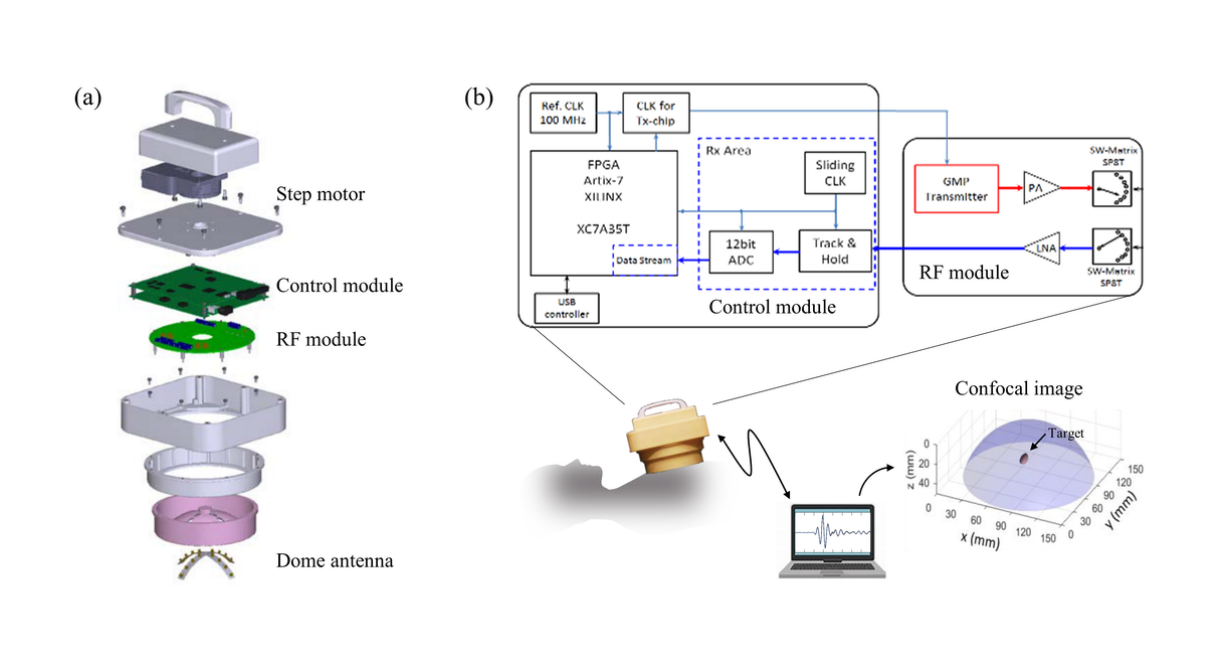
Figure 2. Structure of the microwave breast tumor detector. ADC: analog-to-digital converter; CLK: clock; FPGA: field-programmable gate array; GMP: Gaussian monocycle pulse; LNA: low noise amplifier; PA: power amplifier; Ref. CLK: reference clock; RF: radio frequency; RX: receiver; SP8T: single-pole 8-throw; SW: switching; TX: